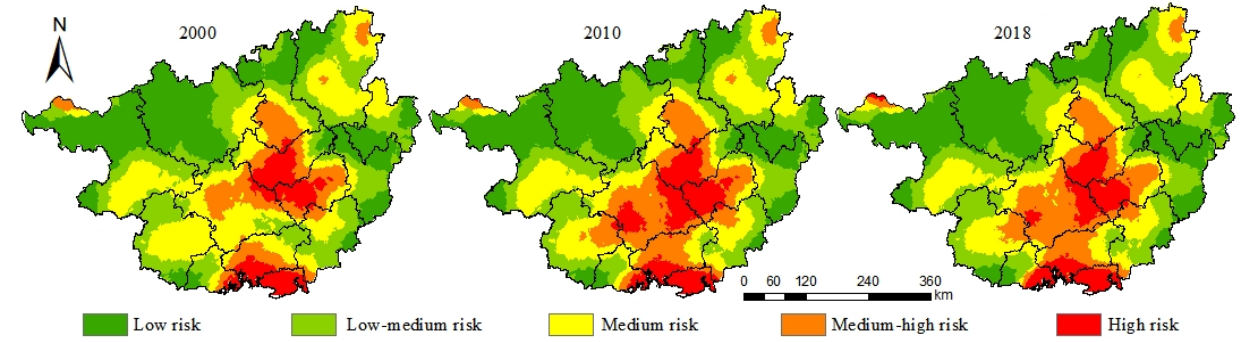
Figure 4. Area map of ecological risk level in Guangxi. Note: 1, 2, 3, 4, and 5 represent low risk, low–medium risk, medium risk, medium–high risk, and high risk, respectively.